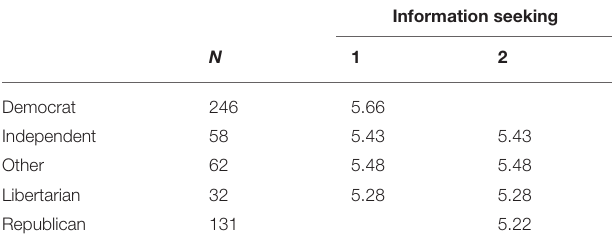
TABLE 5 | Tukey summary hypothesis